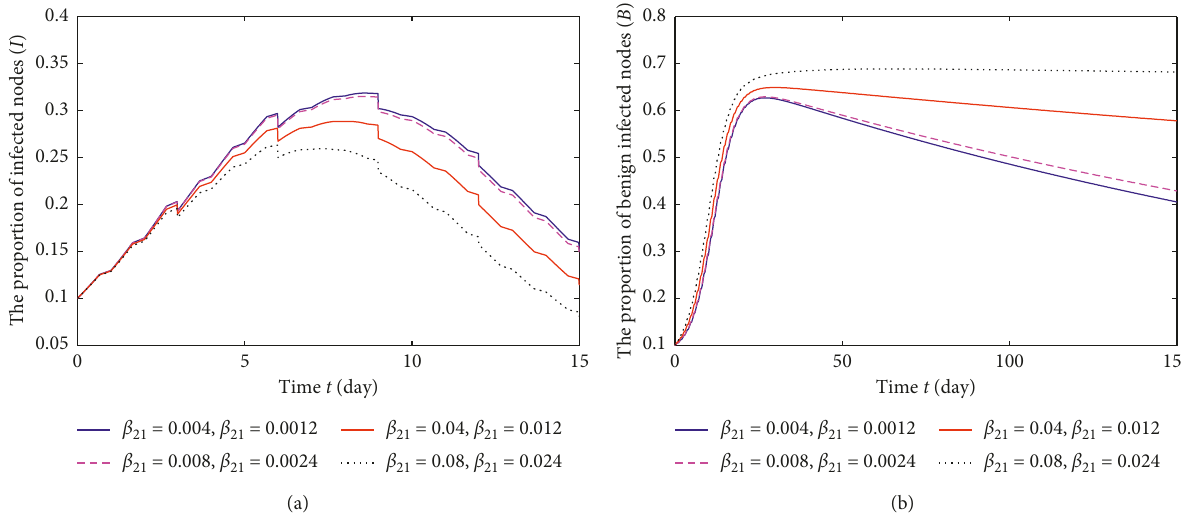
Figure 6: Evolution of I ( t ) and B ( t ) of system (5) for the different values of infection rate β